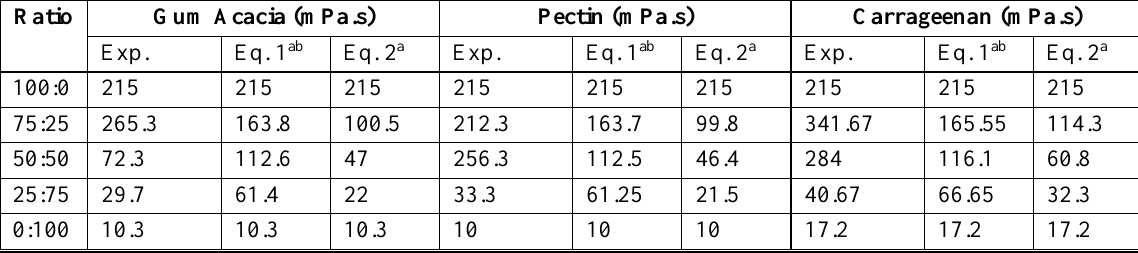
Table 4. Estimation of the apparent viscosity of alginate mixture with CaCl 2 Ratio